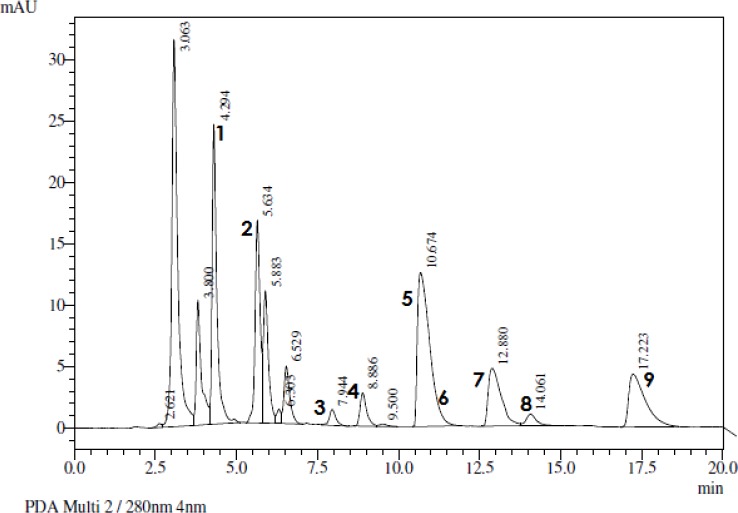
HPLC chromatogram obtained from natural CNLS, cardol (1, 2 and 3), cardanol (4, 6 and 8), and anacardic acid (6, 7 and 9).